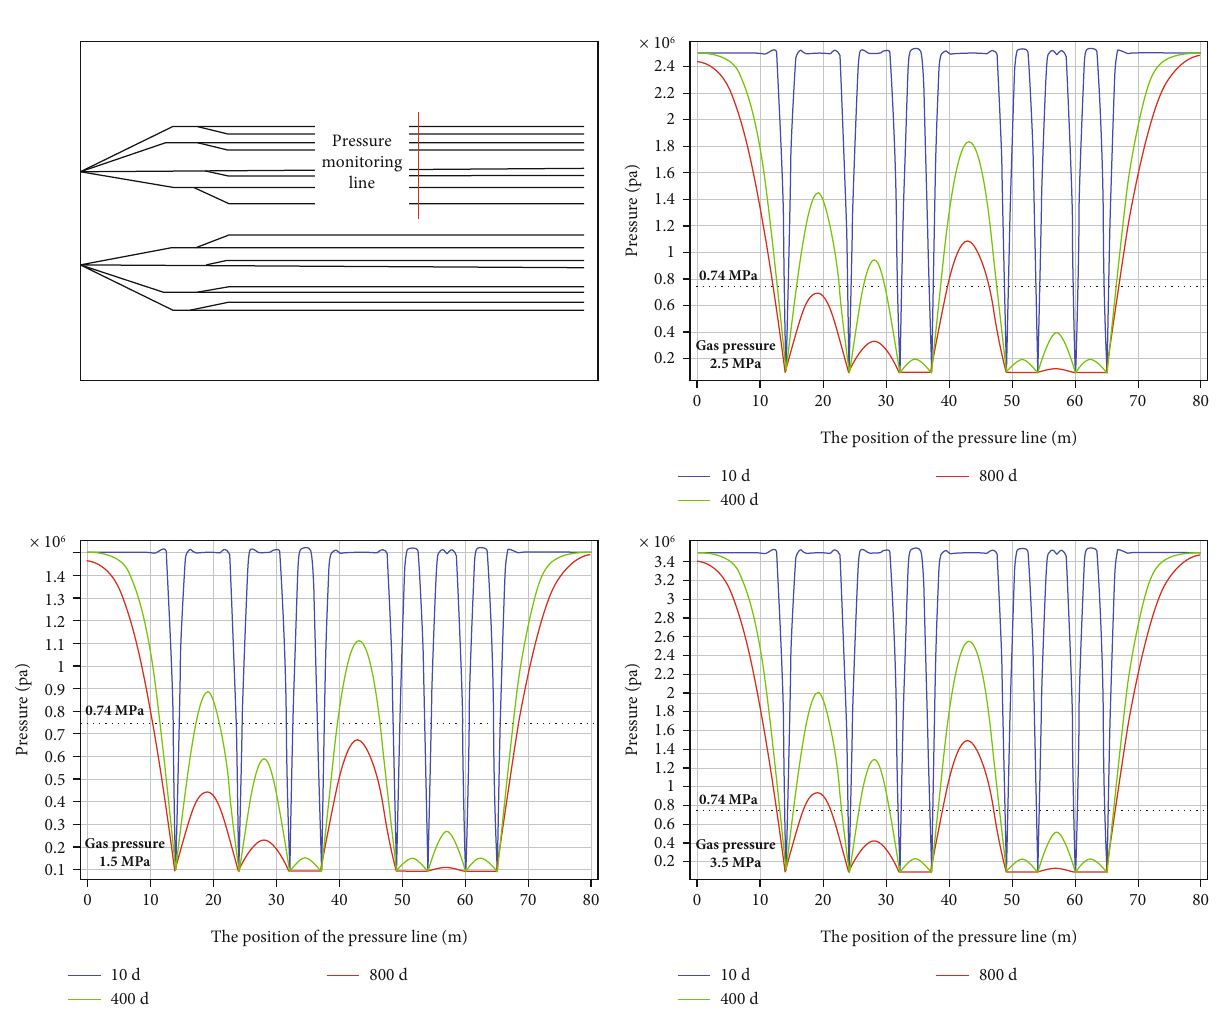
Figure 5: Comparison of extraction e ff ects under di ff erent original gas